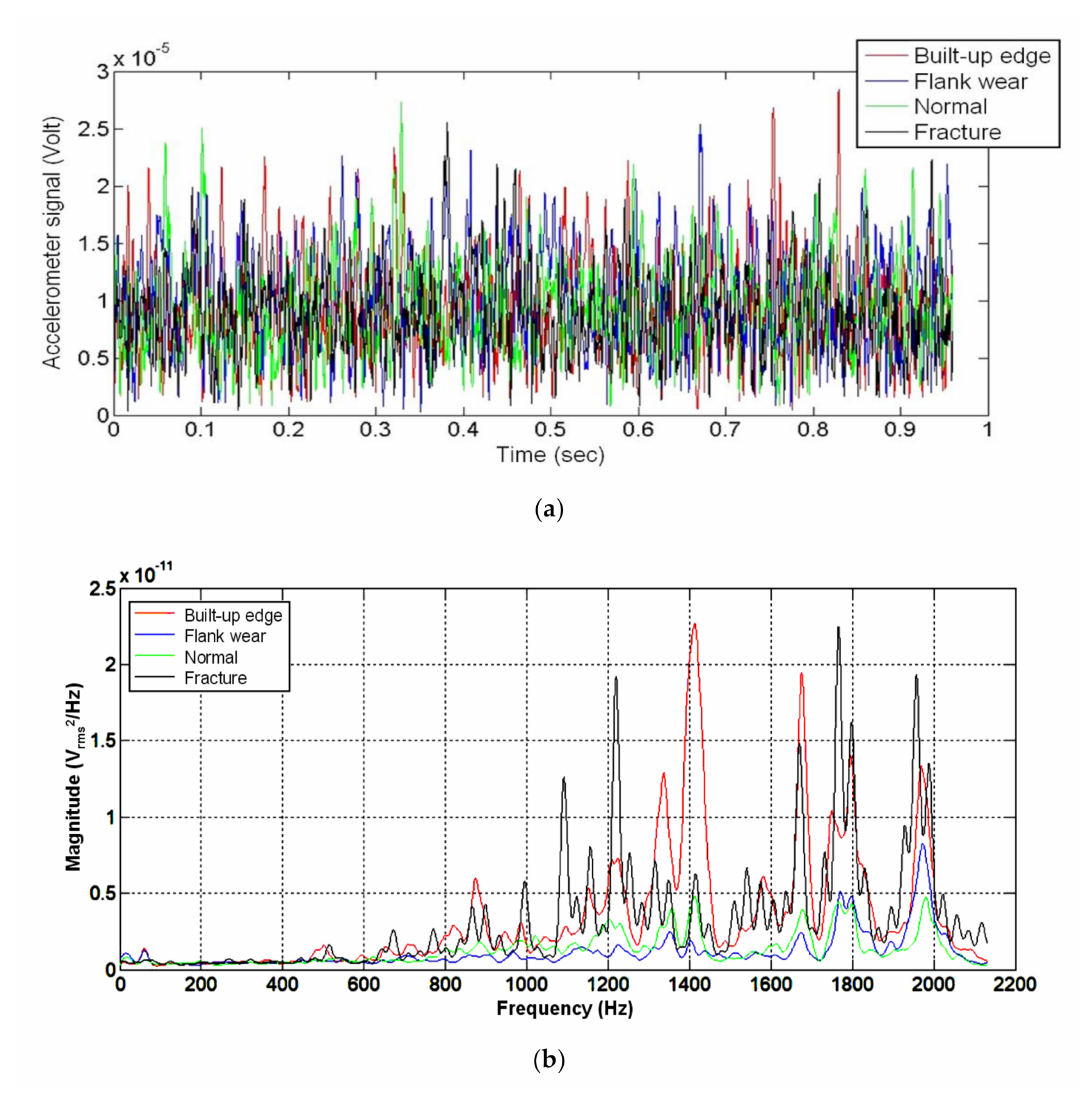
Figure 3. Accelerometer signal time-domain and resultant power spectral density (PSD) distribution diagrams of di ff erent insert conditions. ( a ) Time-domain diagram of di ff erent insert conditions; ( b ) Resultant PSD distribution diagram of di ff erent insert